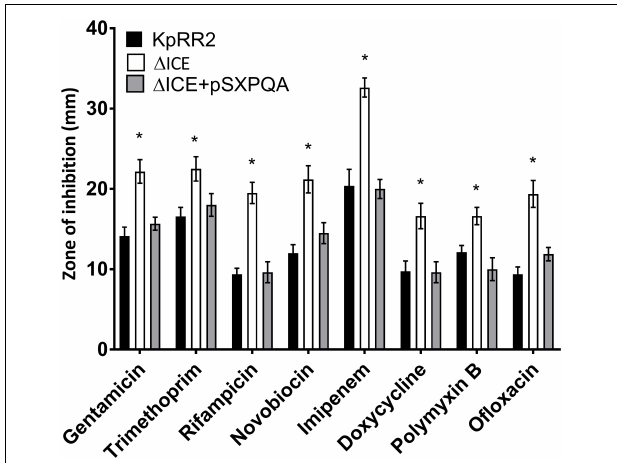
FIGURE 3 | Deletion of the integrative and conjugative element ICEKp from K. pneumoniae rendered it more sensitive to multiple classes of antimicrobial, and the effect could be reversed by reintroduction of the yersiniabactin transporter gene cluster. A deletion mutant lacking the entire ICEKp element, (cid:49) ICE, had a significantly larger zone of inhibition than the parent strain KpRR2 for all antimicrobials tested. Reintroduction of the yersiniabactin transporter gene cluster on plasmid pSXPQA restored the zone size to that of the parental strain. Data show the mean and standard deviation of three replicates. The quantity of antimicrobial per disk was: gentamicin 10 µ g, trimethoprim 5 µ g, rifampicin 5 µ g, novobiocin 30 µ g, imipenem 10 µ g, doxycycline 30 µ g, polymyxin B 300 µ g, ofloxacin 5 µ g. Each strain was compared with the parent strain by Student’s t test, and significant differences in zone diameter were indicated with an asterisk. * p <